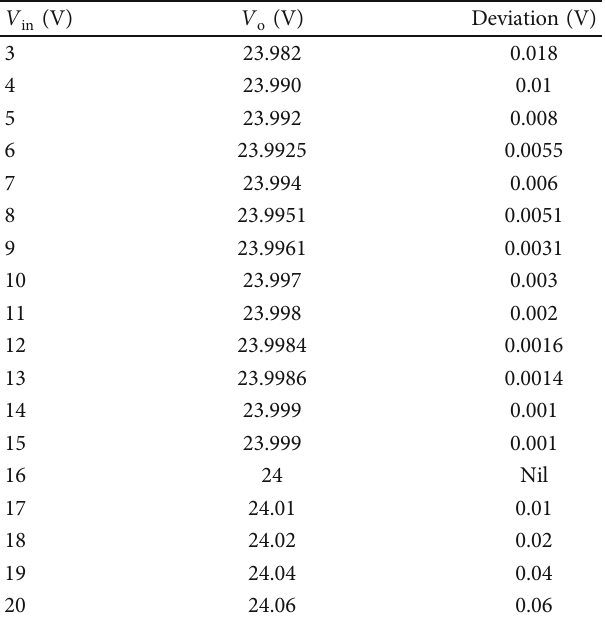
FKYBC for fi xed V = 16V o in : 00053s and d = 0 = 24V ref